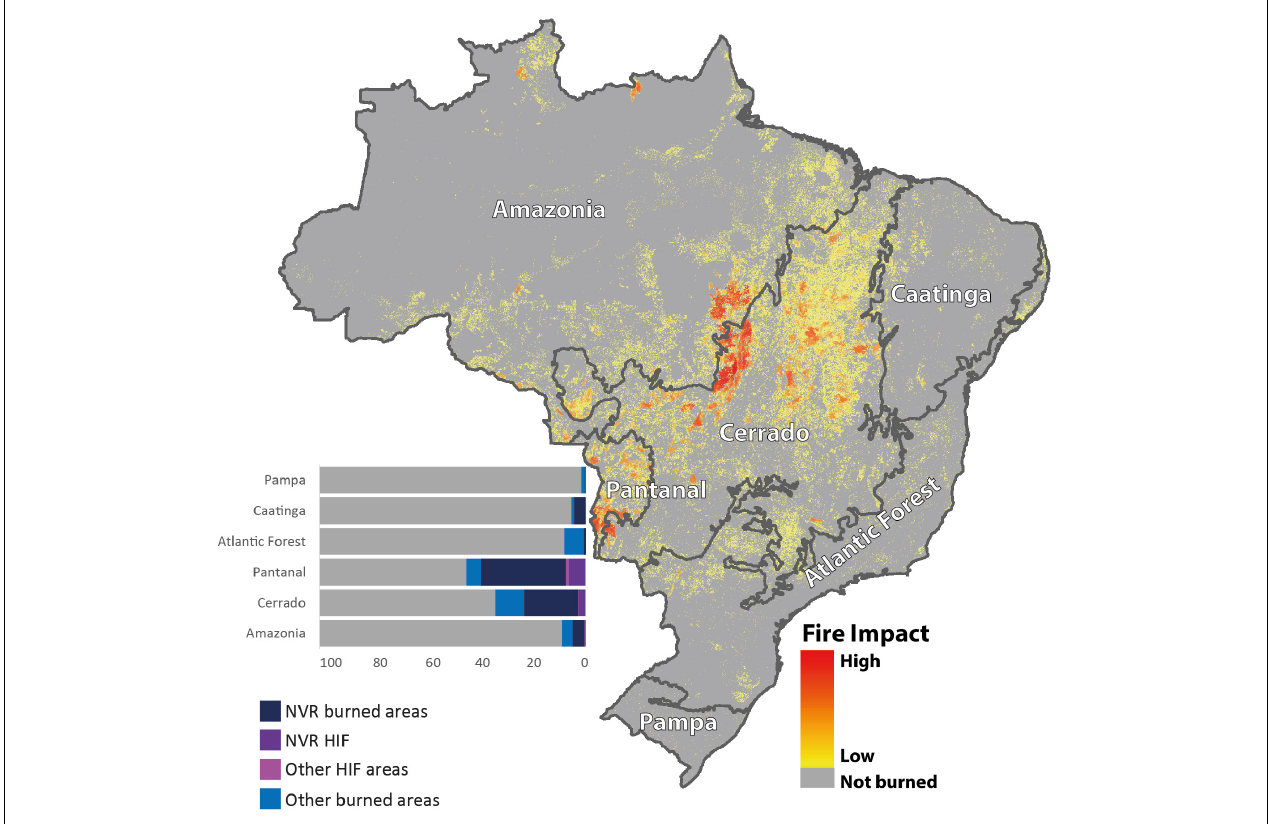
FIGURE 1 | Fire impact derived from the first PC. Bar graphs indicate the proportion of burned areas and HIF in native vegetation remnants (NVR) and in relation to the biome’s